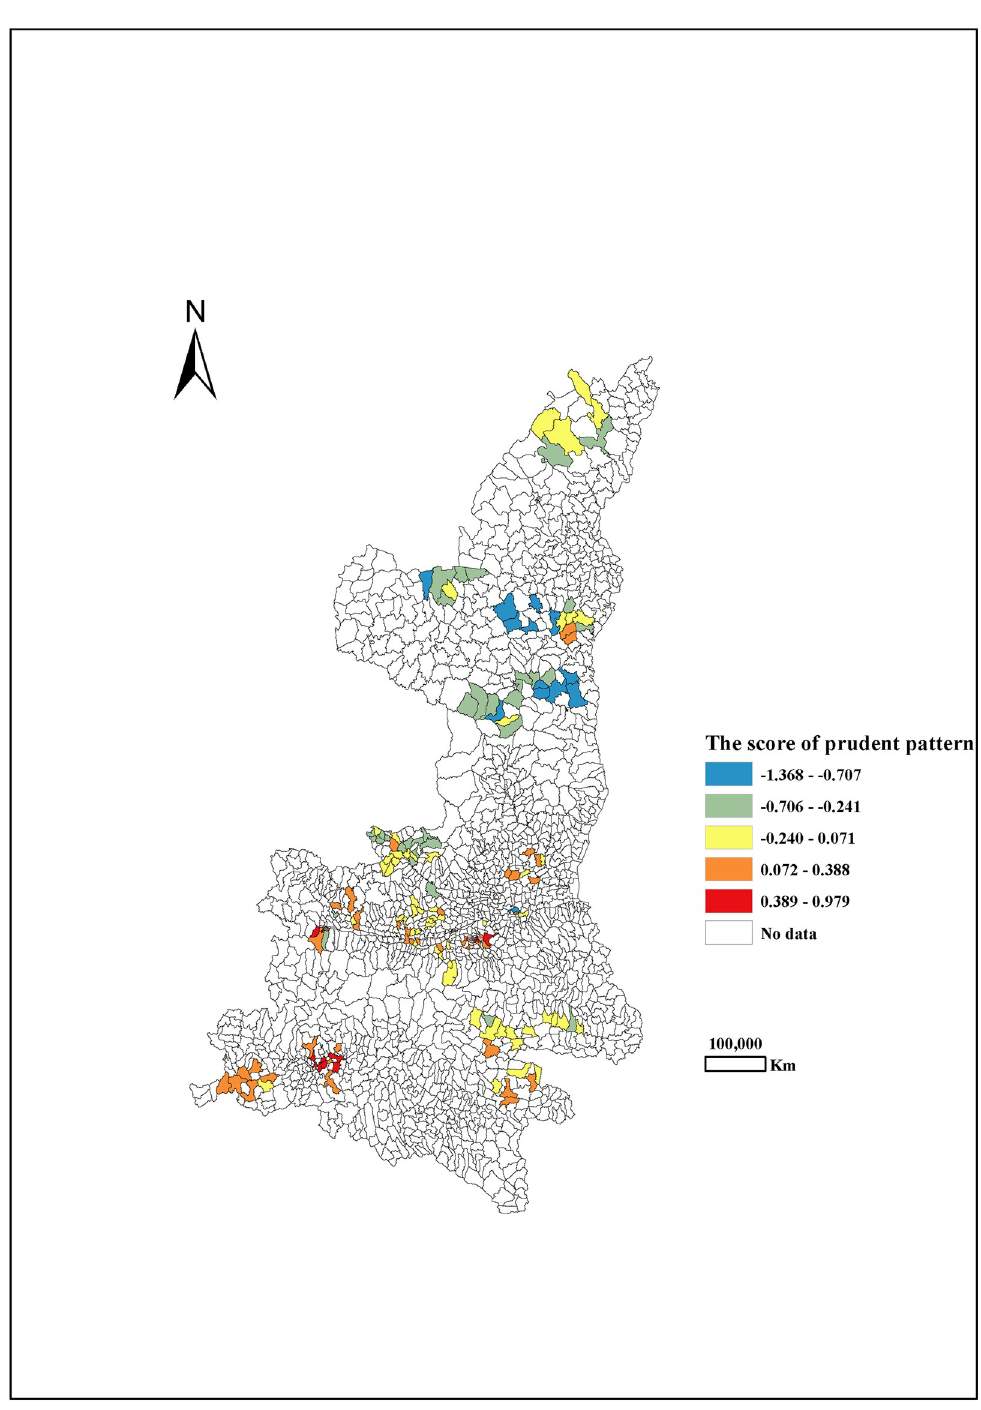
Fig 3. The score of prudent pattern among pregnant women by different areas in Shaanxi province, 2013.